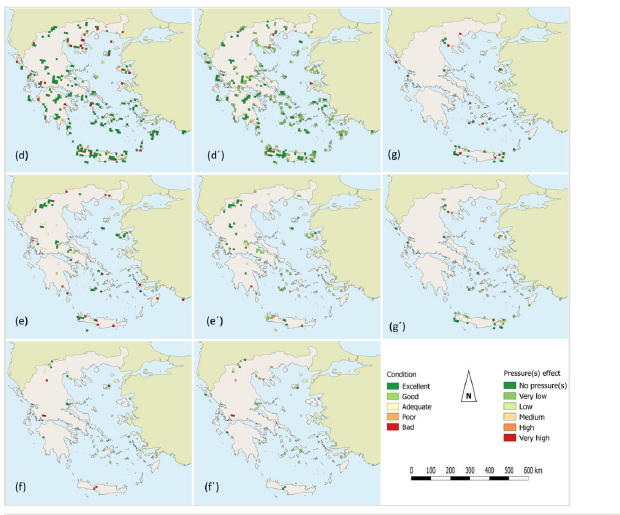
Figure 4. Mapping of the ecosystem types’ condition (EEA 10 km grid cell analysis) for: (d) sparsely vegetated land, (e) rivers and lakes, (f) wetlands and (g) marine inlets and transitional waters. Pressure(s) cumulative e ff ect for each ecosystem type is presented in plates (d ΄ ), (e ΄ ), (f ΄ ) and (g ΄ ),